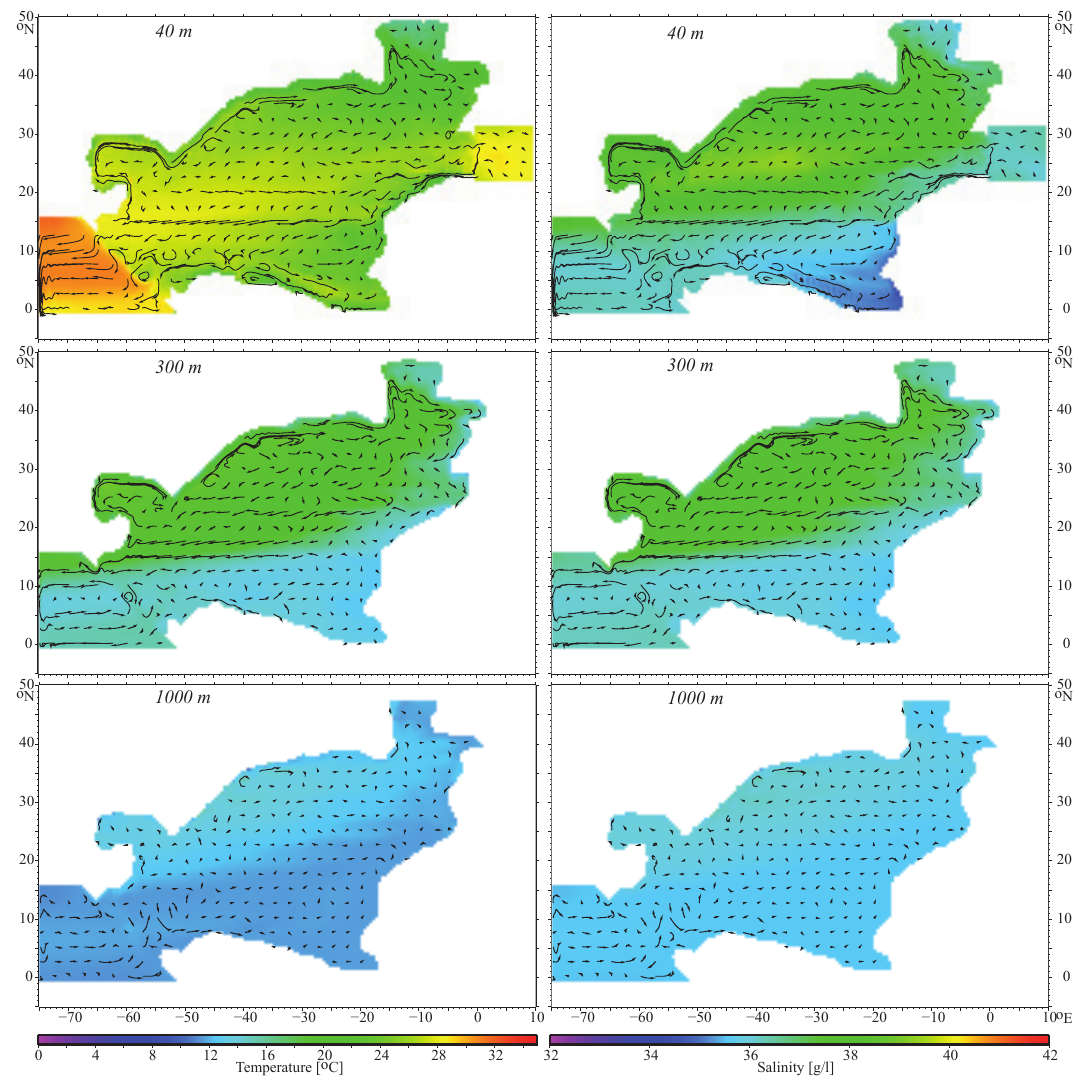
Fig. 11. LOWSL-TET tracer patterns. Temperature (left) and salinity (right) slices taken at depths of 40, 300 and 1000m from the LOWSL- TET experiment. The paths of waterparticles of every fifth grid point followed for 42, 84 and 114 days are overprinted on the tracer